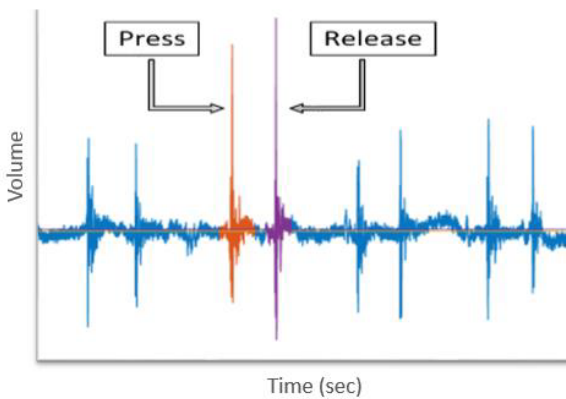
Figure 4. Press and Release region in a keystroke generated acoustic signal.